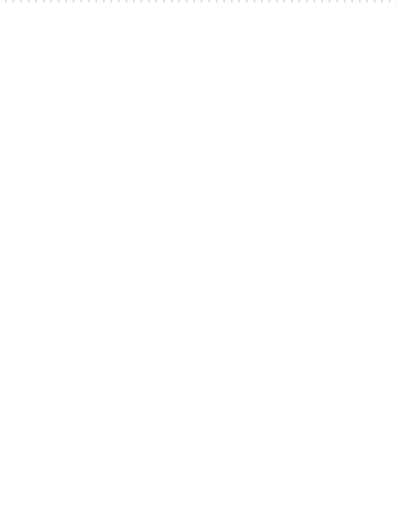
Figure 12. Radial distribution of the temperature ( a ) simple, ( b ) sinusoidal, ( c ) triangular, ( d ) square tube in presence of different magnetic fields.